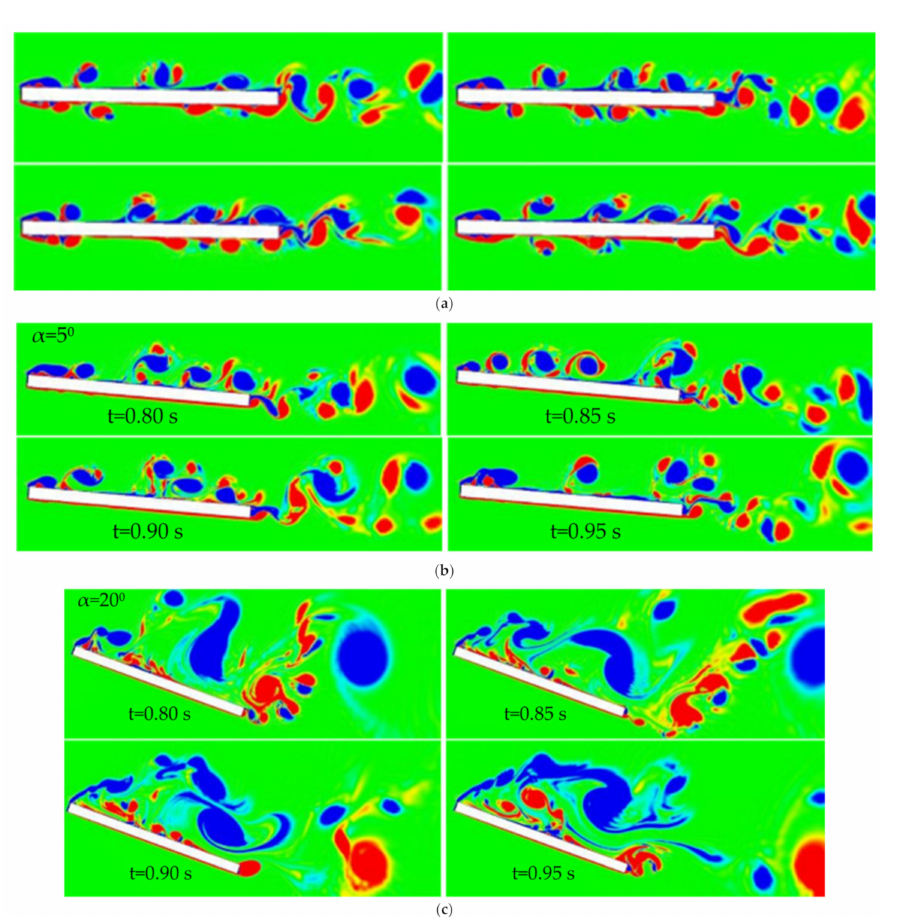
Figure 10. Temporal variability of the flow patterns around a tilted plate: vorticity field at different time instances T b = 5.2 s, N = 1.2 s − 1 , L = 10 cm, U = 1.0 cm/s: ( a – c )— α = 0, 5 ◦ , 20 ◦ , red and blue colors in the color spectrum correspond to positive and negative values of the vorticity field within the range, − 100 < ω < 100 s − 1 , and green color corresponds to zero value of